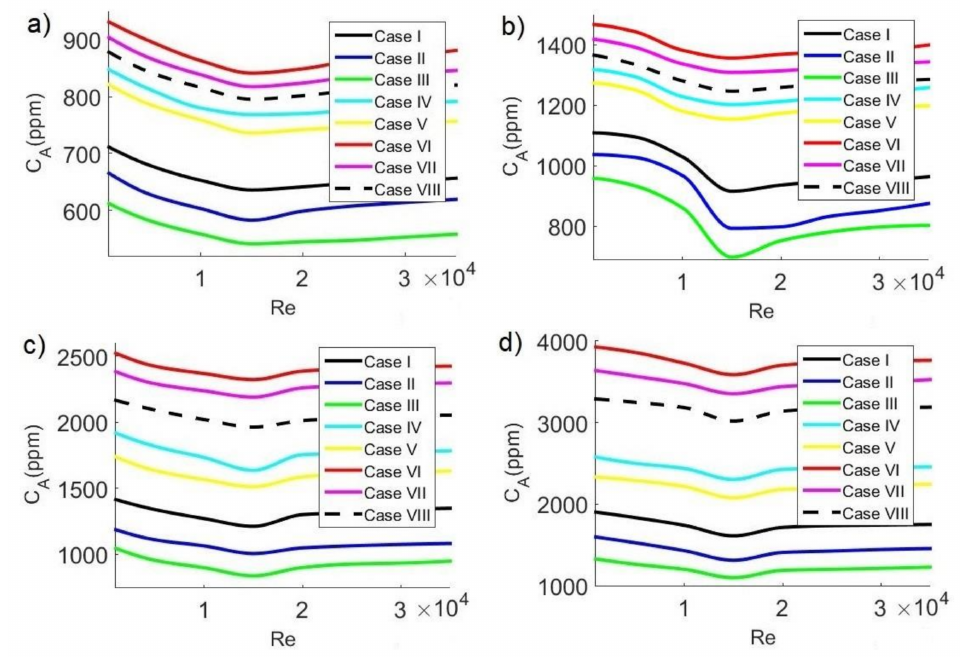
Figure 12. Average concentration of CO 2 in the classroom as a function of Reynolds number at 6:30 p.m. with CO 2 sources of: ( a ) 35,000 ppm; ( b ) 37,500 ppm; ( c ) 40,000 ppm; ( d ) 42,500